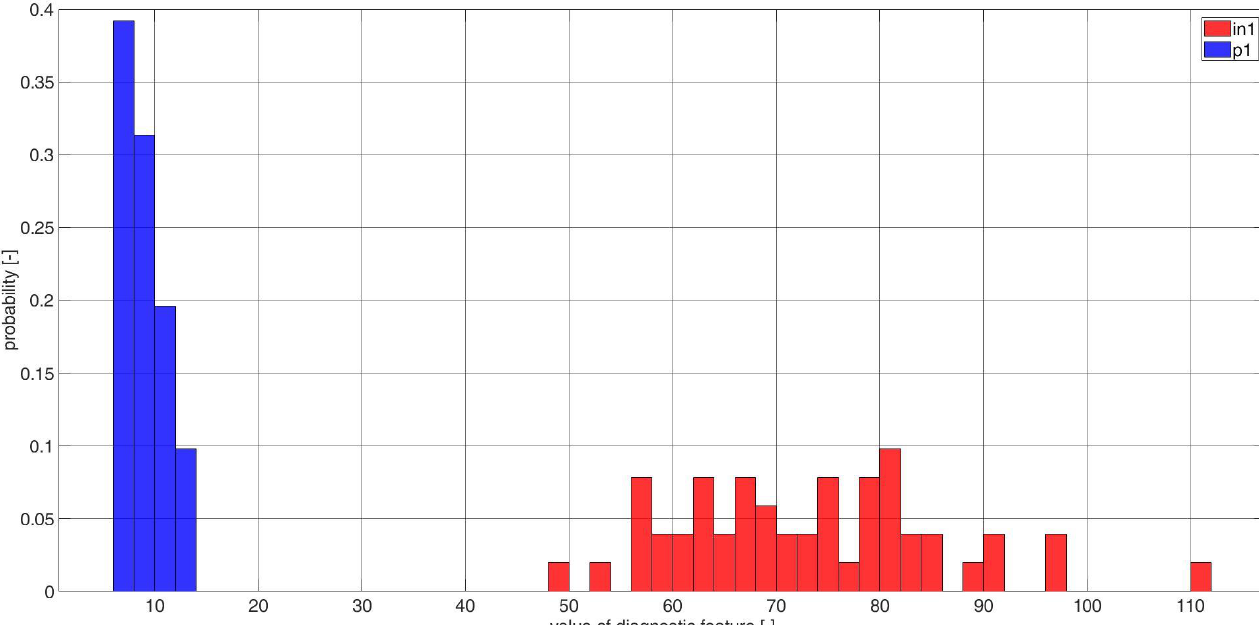
Figure A4. Histograms of diagnostic features based on the CCSM3 (correlation number is 5 — Table A1) bearings in2 and p2.